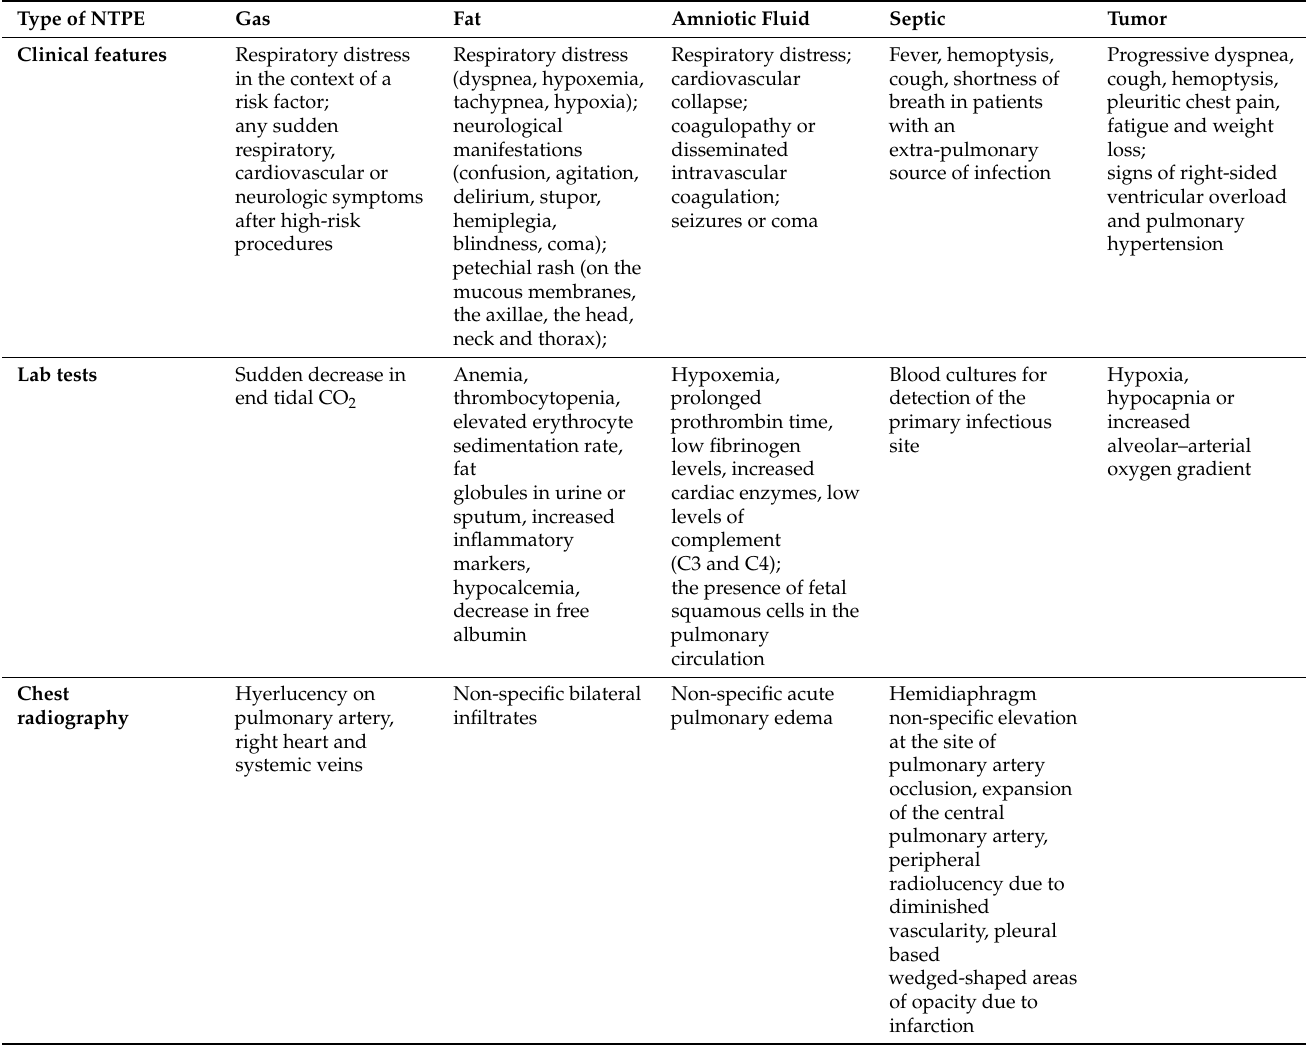
Table 2. Specific features for each type of